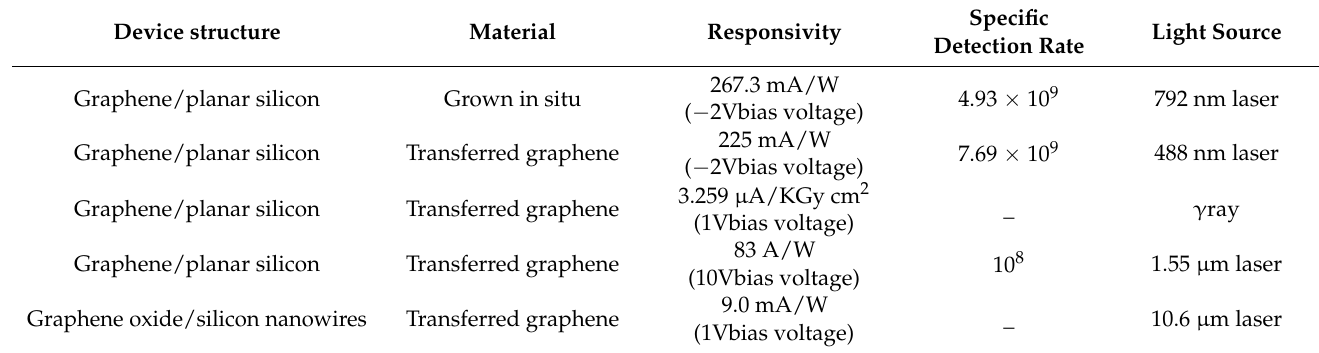
Table 2. Comparison of Silicon-Graphene Schottky junction Photoelectric